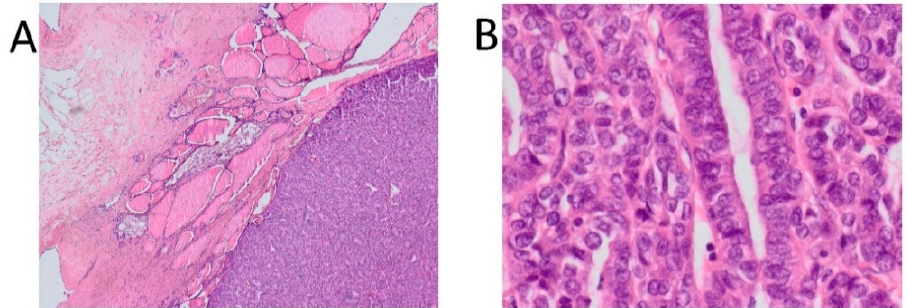
Figure 2. Gross photographs of surgical specimens. ( A ) 40 × magnification, hematoxylin and eosin (H&E) staining; the ovarian capsule is visible on the top-left side, struma ovarii is visible in the middle of the image, and violet-stained follicular variant of papillary carcinoma on the right. ( B ) 200 × magnification, H&E staining, papillary carcinoma; visible cytological features of the cancer include cell overlapping and cell nuclei